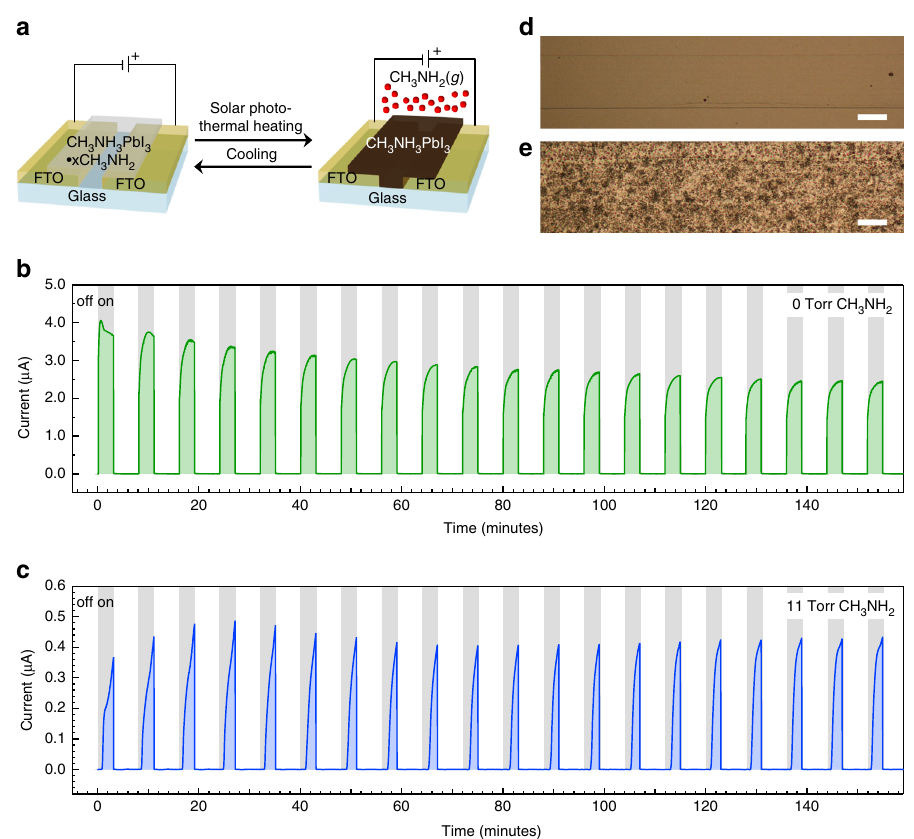
Fig. 4 Switchable photoresistors to determine PV device degradation. a Diagram illustrating switchable photoresistors. b , c Current as a function of time for 20 cycles of 3-min illumination followed by 5 min of cooling in the dark for a photoresistor in the presence of 0 Torr ( b ) and 11 Torr ( c ) partial pressure of CH 3 NH 2 gas. Photoresistors were operated at a constant voltage of 0.65 V, which corresponds to the maximum power point voltage of the highest performing switchable PV devices. d , e Optical photographs of the photoresistor channel after 20 switching cycles in the presence of 0 Torr ( d ) and 11 Torr ( e ) partial pressure of CH 3 NH 2 gas. Scale bars are 25 μ